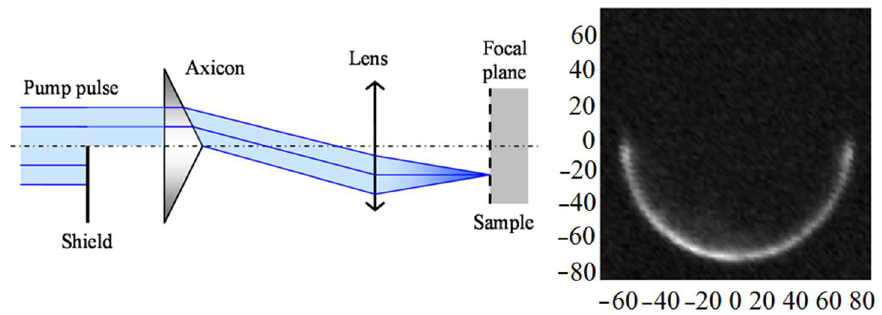
Figure 7. Left: scheme used to obtain a half-ring excitation. Right: intensity distribution measured on the sample surface.